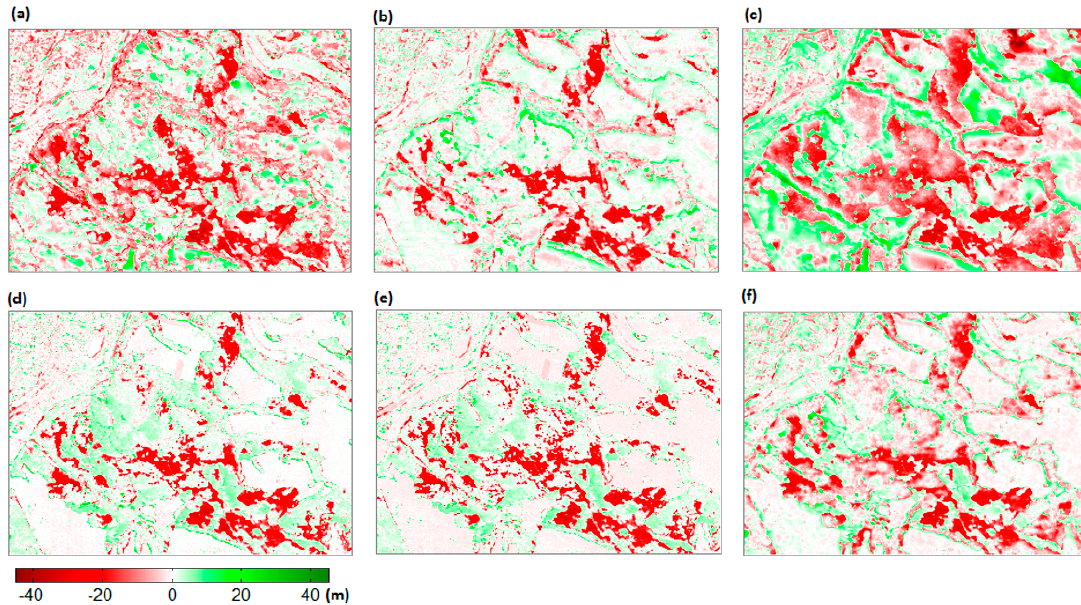
Figure 9. Height difference maps comparison: ( a ) ALOS2008–HRSC2003; ( b ) Cartosat2008–HRSC2003; ( c ) RapidEye2009–HRSC2003; ( d ) WorldView2012–HRSC2003; ( e ) Aerial2012–HRSC2003; and ( f ) TanDEM-X2013–HRSC2003.